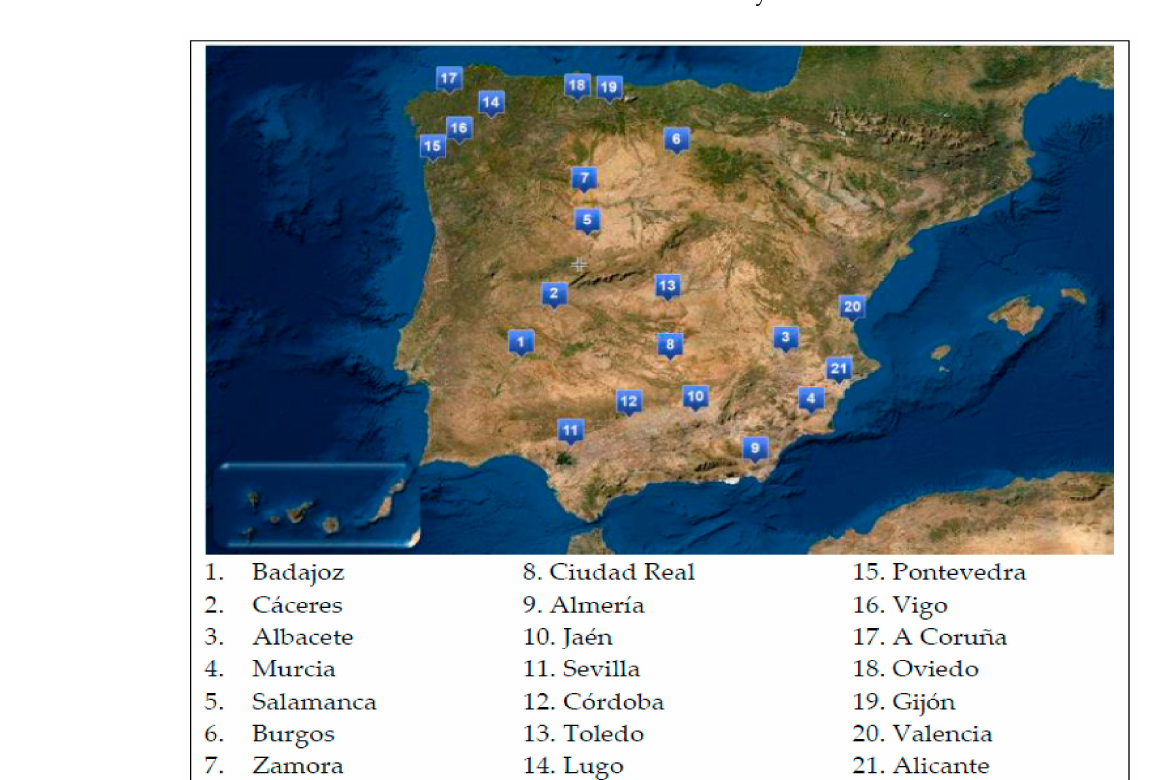
Figure 1. Map of provenance of tourism planning services. Source: